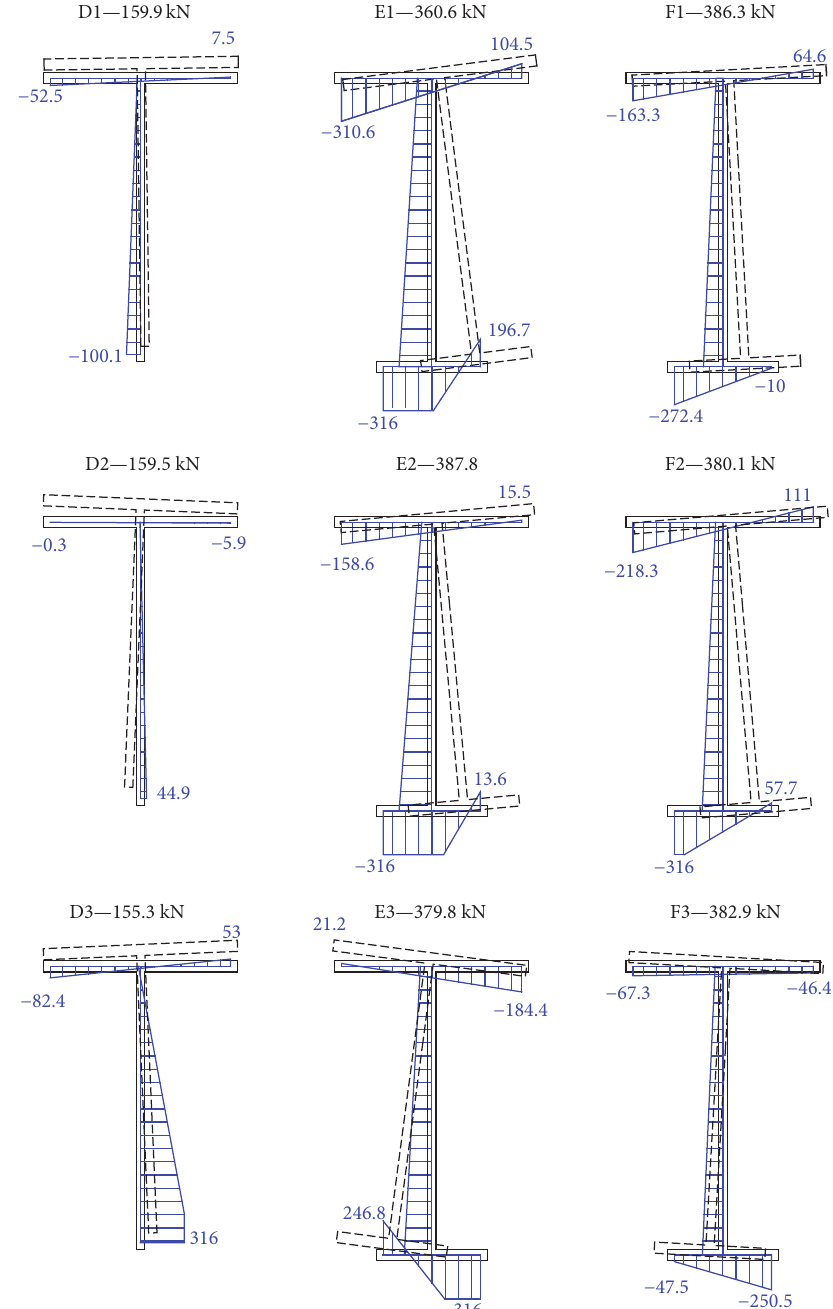
Figure 6: Experimental results at the moment of collapse: load resistance, stresses recalculated from strain gauges [MPa], and deflections.